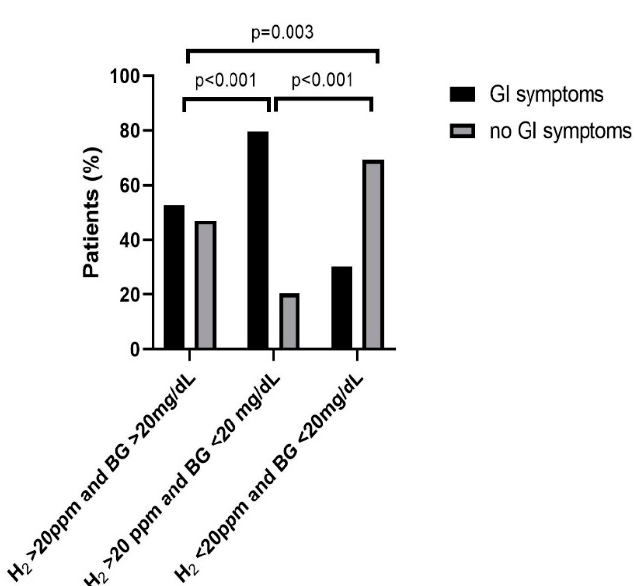
Figure 2. Three hundred eighty five of 402-LIT patients indicated GI symptoms during their lactose H 2 breath tests. Abbreviations: BG, blood glucose; GI, gastrointestinal; H 2 , hydrogen; LIT, lactose intolerance; ppm, parts per million.